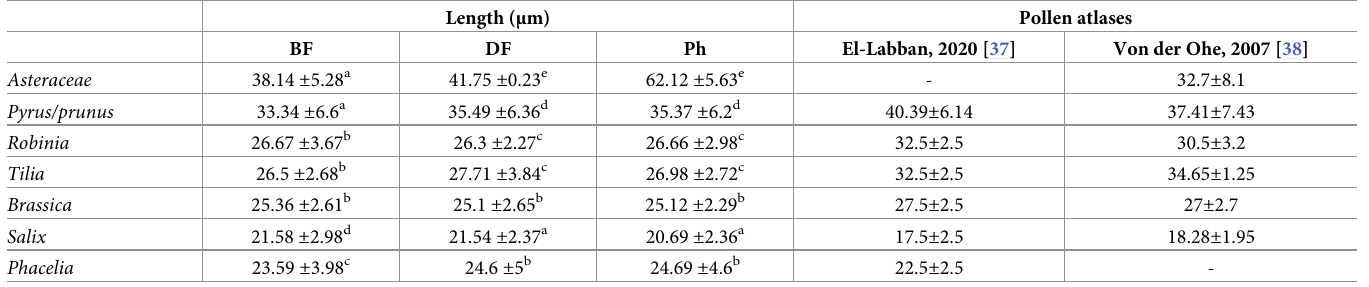
Table 2. Comparison of the length of different pollen taxa between microscopy methods and pollen